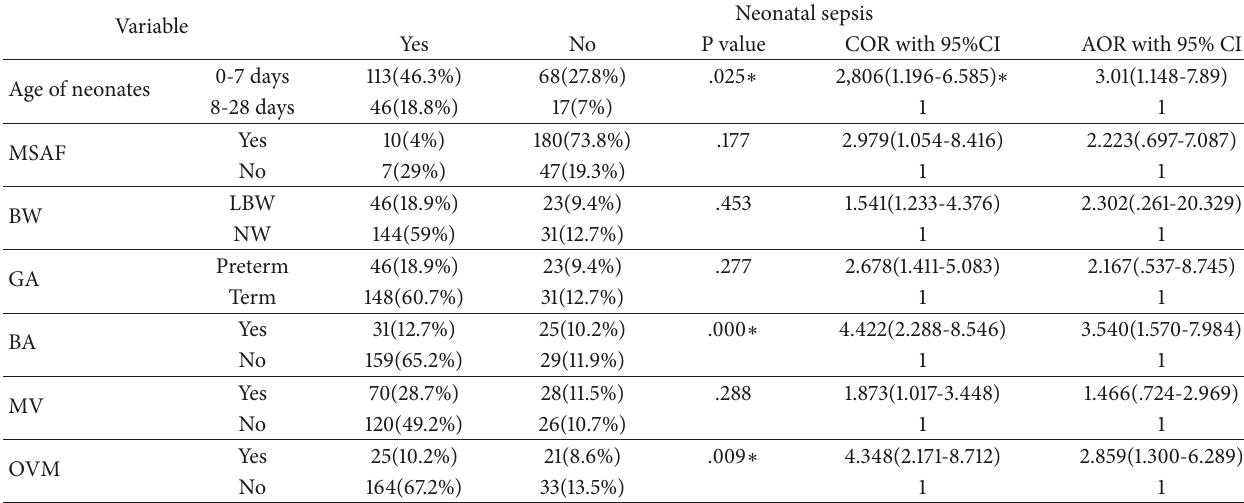
Table 5: Bivariate and multivariate analysis showing the association between neonatal sepsis and others different variables in neonates admitted to Shashemene governmental hospital, NICU, Ethiopia, 2017, GC .